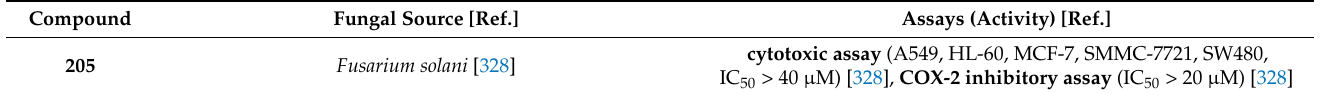
Table 8. Sources and biological activity of fungal degraded